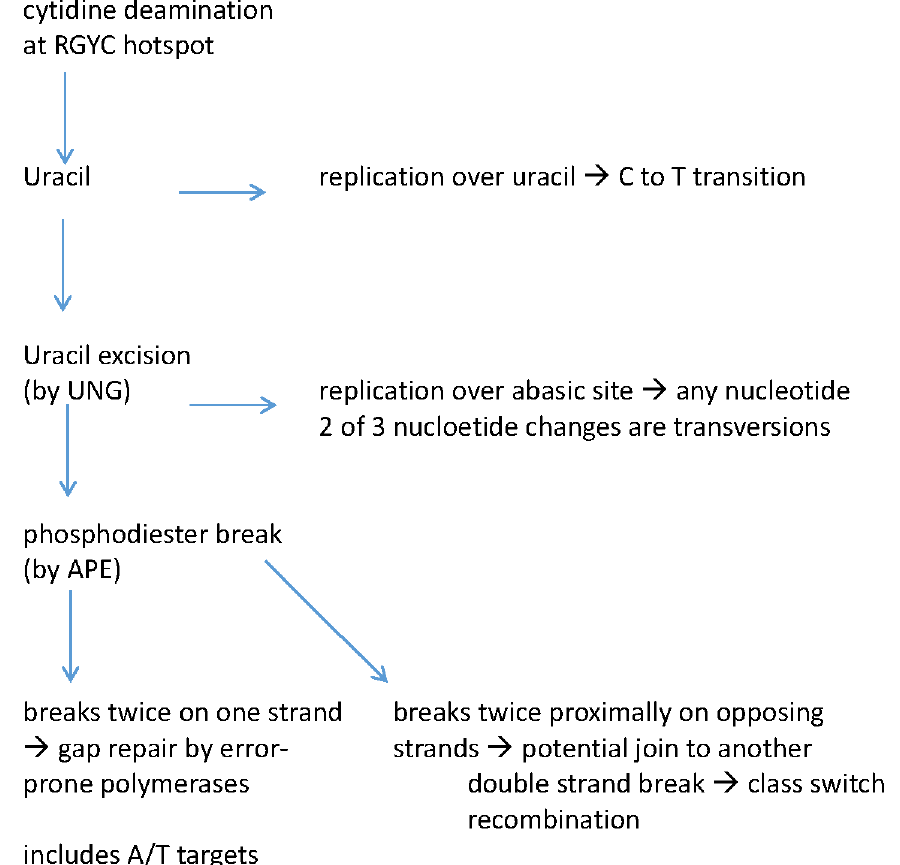
Figure 1. Schematic of outcomes of activation induced cytidine deaminase (AID) mediated cytidine deaminations in immunoglobulin genes. AID targets cytidines within the RGYW hotspot motif. UNG—Uracil-DNA-glycosylase; APE—apurinic/apyrimidinic